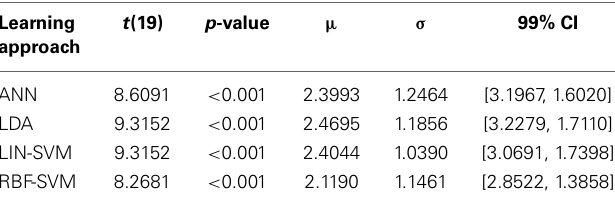
Table 2 | Results of pairwise comparison tests for individual learning approaches compared to their respective empirical null